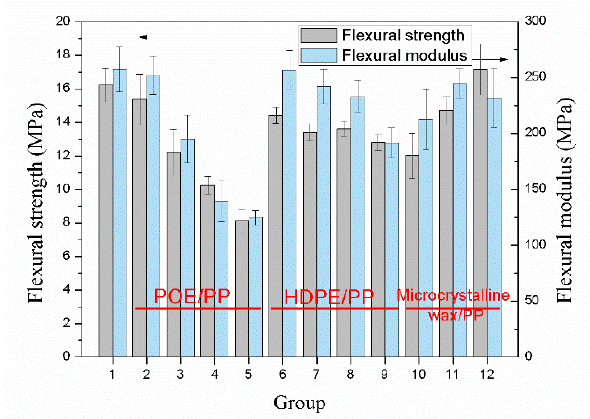
Figure 7. Notched impact strength of the samples with different polymer blends.